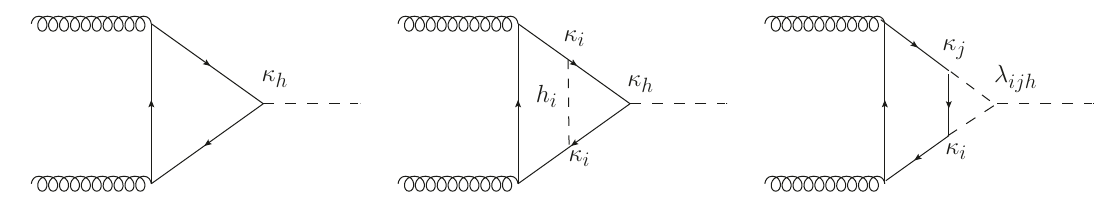
Figure 1 . Feynman diagrams for LO gluon fusion Higgs production (left) and NLO diagrams involving Higgs bosons (centre and right) in GxSM